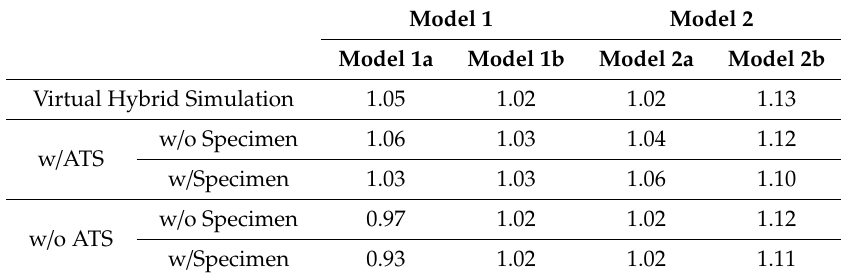
Table 1. NRMSE (%) for brace displacement predictions where ‘first’ force input dimension is updated in RTHS tests.